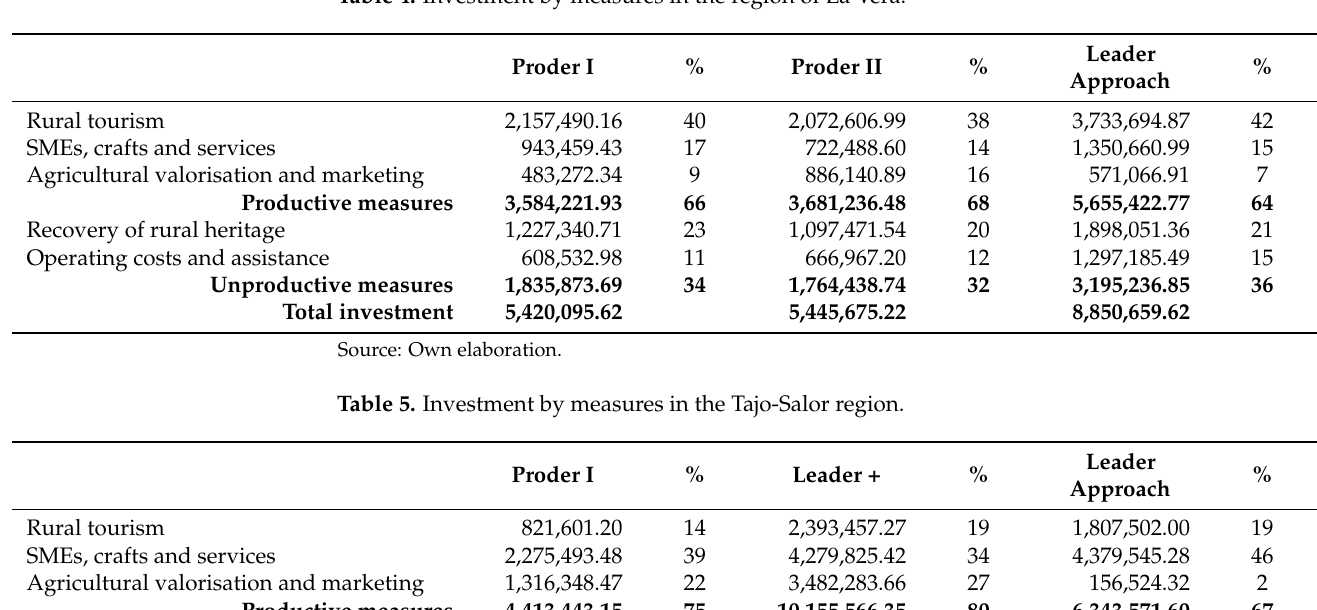
Table 4. Investment by measures in the region of La Vera.